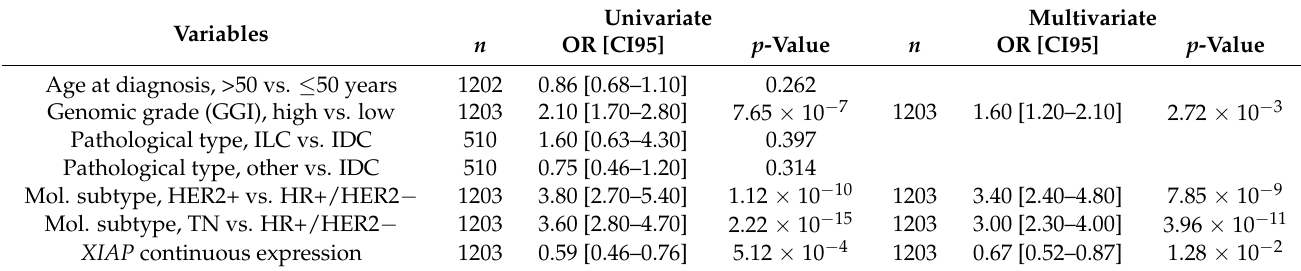
Table 3. Univariate and multivariate analyses for pCR to neoadjuvant